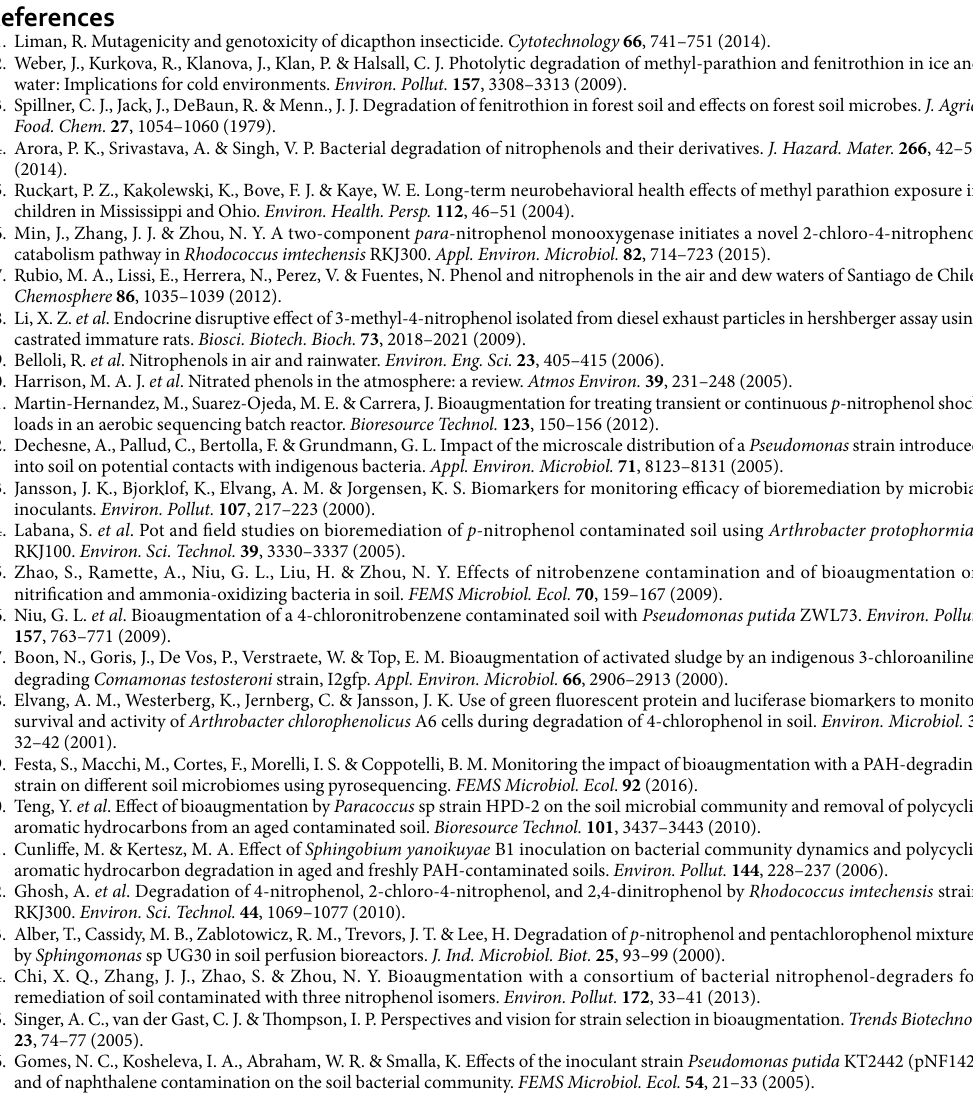
HiSeq sequencing and data processing and analysis. The universal primers F515 and R806 (Table 1) were used to amplify the V4 hypervariable region of 16S rRNA gene for high-throughput sequencing (Novogene Bioinformatics Institute, Beijing, China). The sequence data were analyzed using USEARCH version 9.0 46 . Briefly, the paired reads were merged and filtered using the “-fastq_mergepairs” and “-fastq_filter” commands, respec- tively. Sequences were then clustered into operational taxonomic units (OTUs) using a 97% identity threshold via dereplication (-derep_fulllength), and chimera filtering and clustering (-cluster_otus) were performed. A compiled OTU table was constructed by mapping the reads to OTUs (-usearch_global). Mothur (version 1.36.1) used to classify OTU representative sequences using Silva Release 123 (http://www.mothur.org/) according to the standard operating procedures 47 . Coverage, observed OTUs (Sobs), richness (Chao1 index), and diversity (Shannon index) were calculated using Mothur and used to estimate the α -diversity of each sample. To analyze the succession of bacterial commu- nities at the genus-level, heat map profiles were generated using heat map package in R 48 . Principal